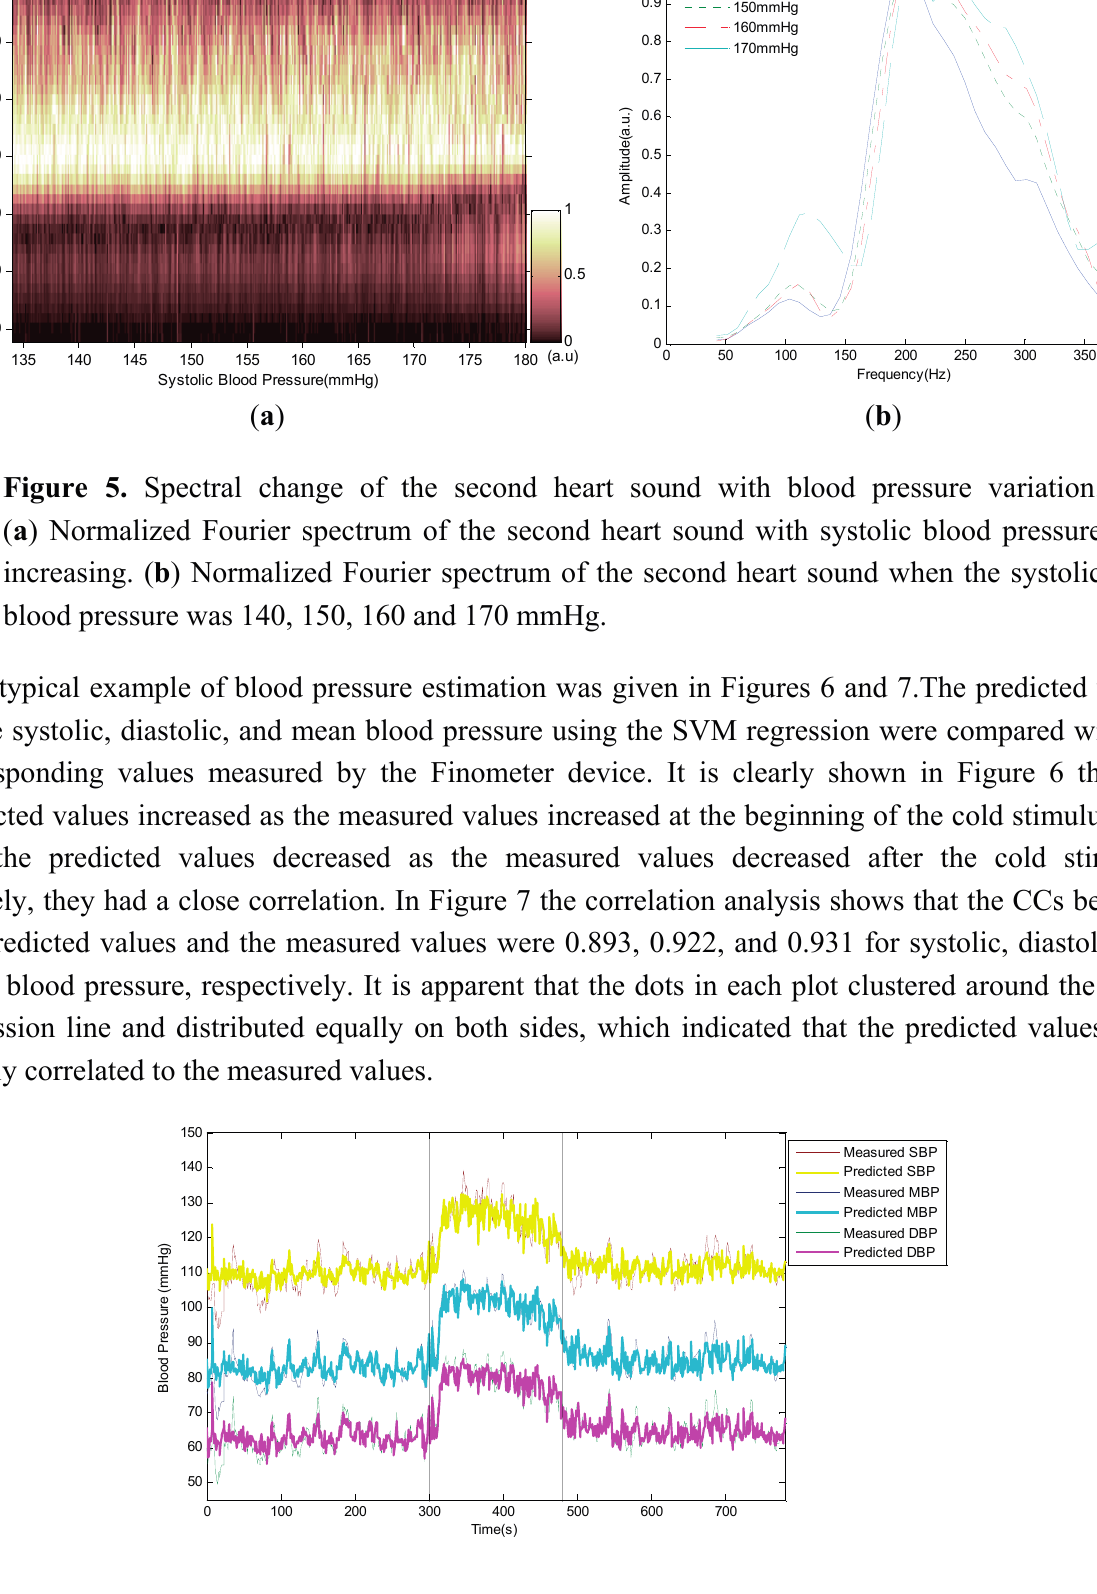
Figure 6. Variation of predicted values and measured values for systolic blood pressure (SBP), diastolic blood pressure (DBP) and mean blood pressure (MBP) during the cold pressor test. The vertical lines indicate the beginning and the end of the cold